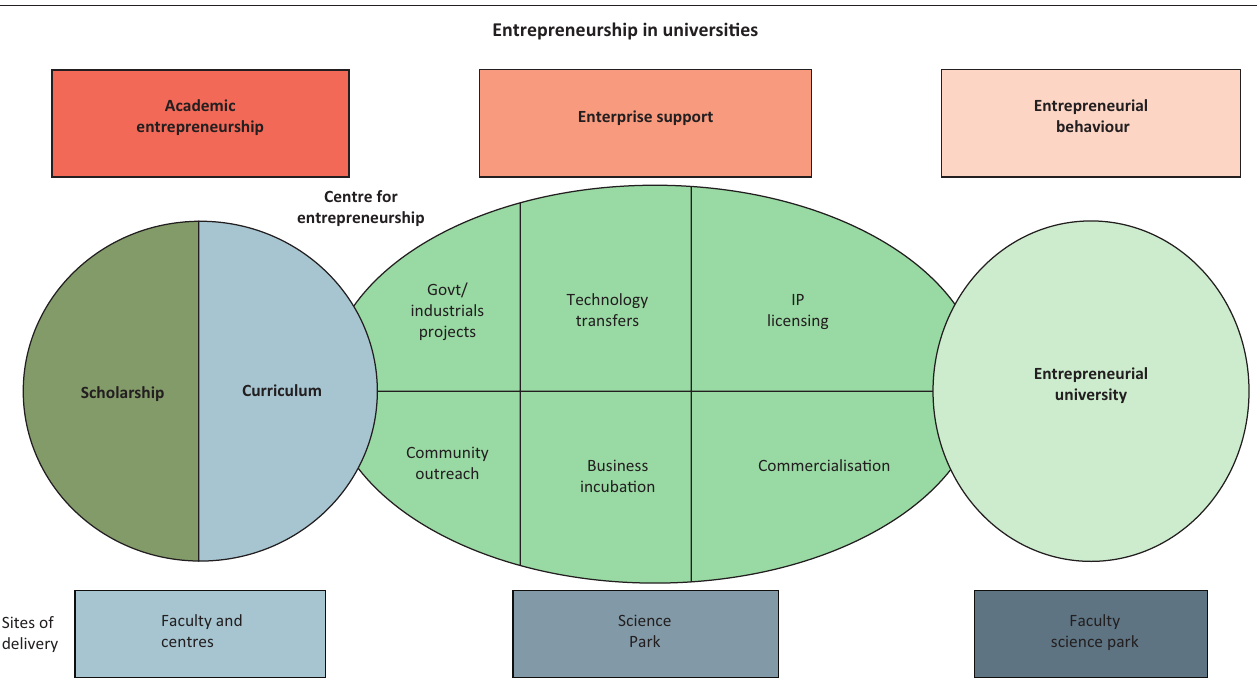
FIGURE 2: A fragmented Model for Entrepreneurship in